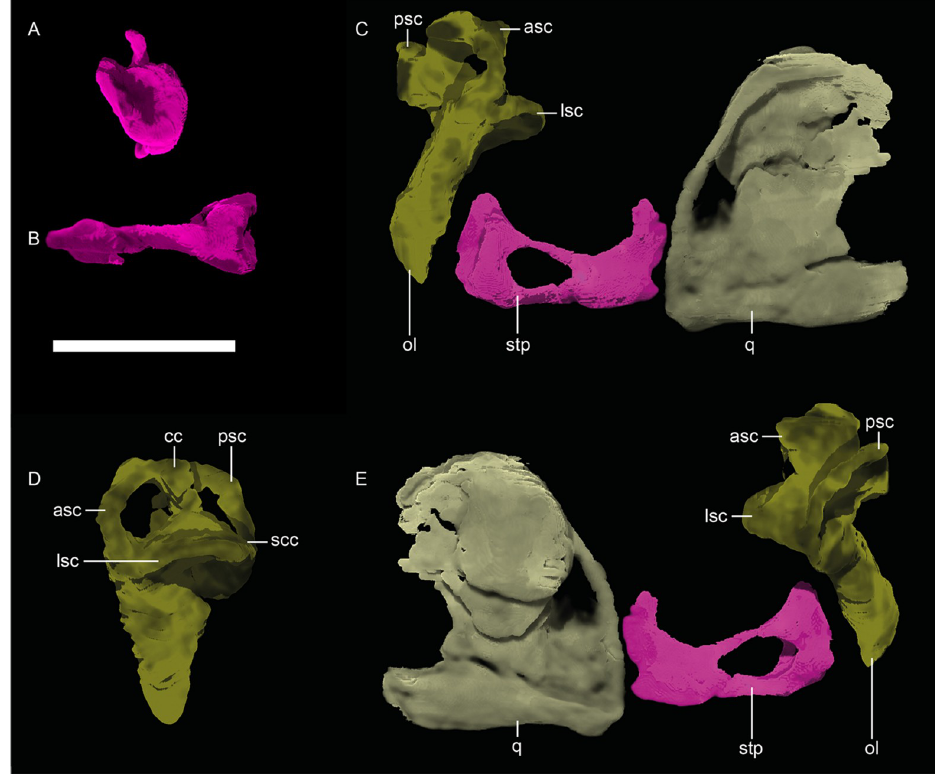
Fig 13. Neutron CT reconstruction of MB.R.999: stapes from (A) medial and (B) ventral; otic ear labyrinth from (C) anterior, (D) left lateral and (E) posterior. Abbreviations: asc, anterior semicircular canal; cc, common crus; lsc, lateral semicircular canal; ol, otic labyrinth; psc, posterior semicircular canal; q, quadrate; scc, secondary common crus; stp, stapes. Scale bar = 1 cm.